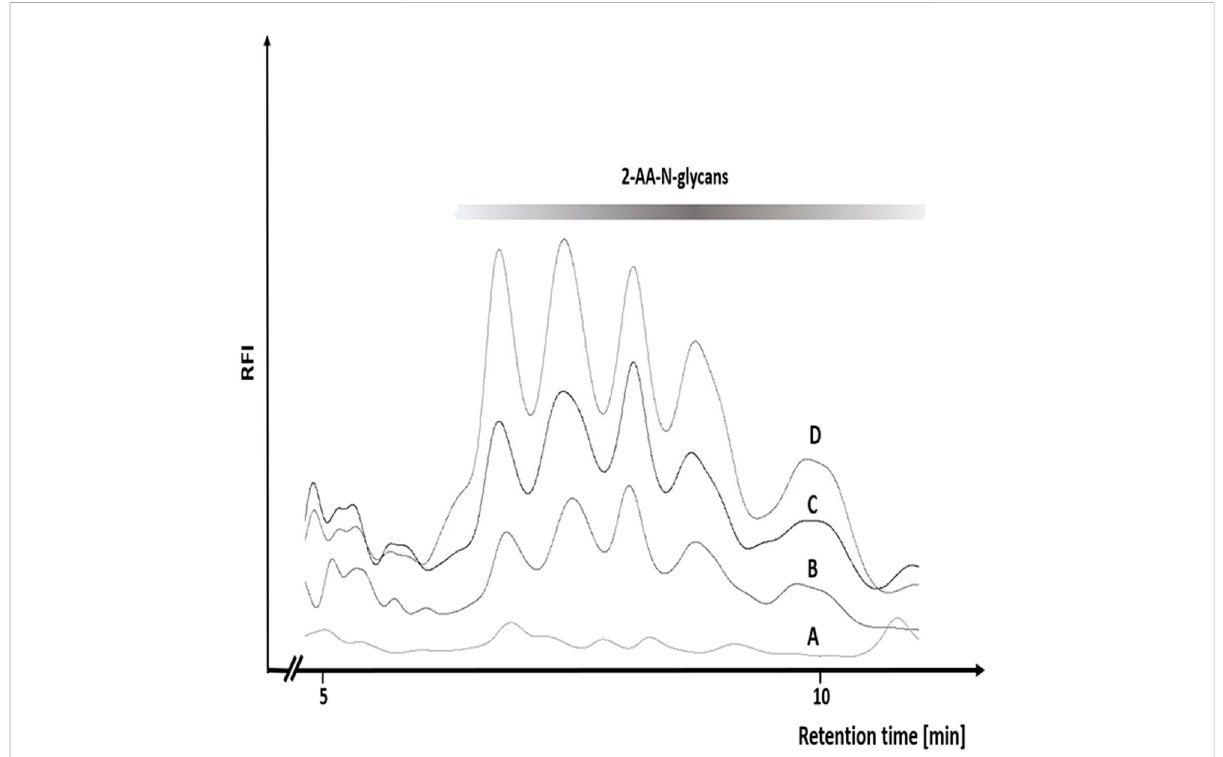
FIGURE 5 Increasingconcentrationsofbromideresultinamoreef fi cientN-glycanreleasefromchickenovalbuminbytheOxone ® /Bromidemethod.RP- HPLC-FLDpeakpro fi lesfortherespective2-AA-labeledN-glycansreleasedbyeitherOxone ® alone (A) ,Oxone ® /Bromidemixturewith2.1 (B) 3.3 (C) and14.4 (D) molarexcessofbromide:Oxone ® .Column:OTUTriKalaC18150×3 mm,isocraticsolvent:10%Acetonitrile/0.1%formicacid, fl owrate: 0.5 ml/min., column temperature: 25 ° C, fl uorescence detection: λ ex = 360 nm, λ em = 420 nm; GAIN